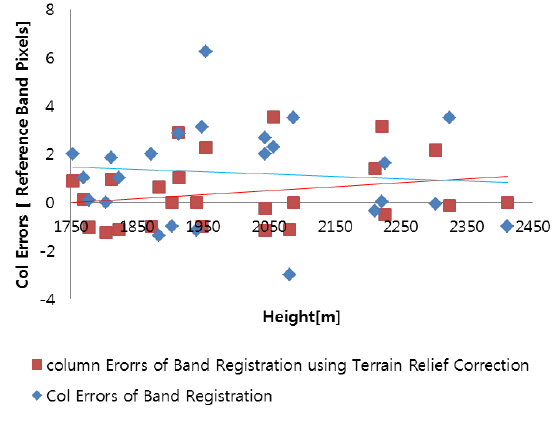
Figure 6. Column Errors depending on Height of band registration using terrain correction and without